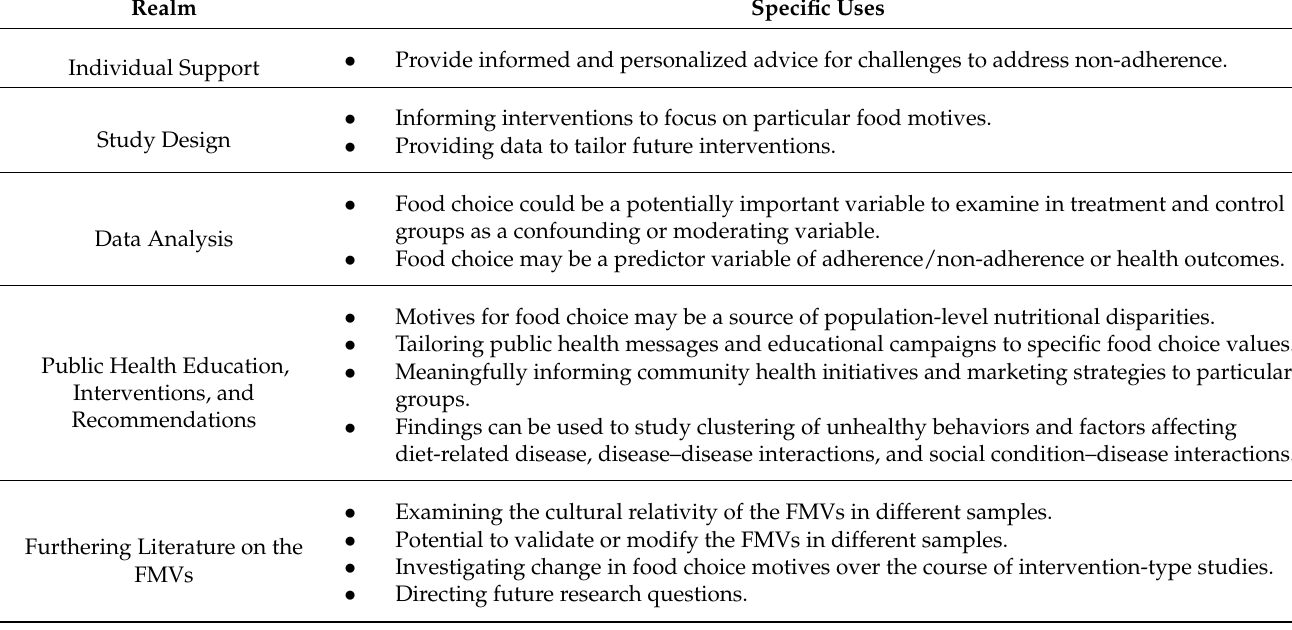
Table 3. Potential uses of food motives and values measures summarized. Realm Specific